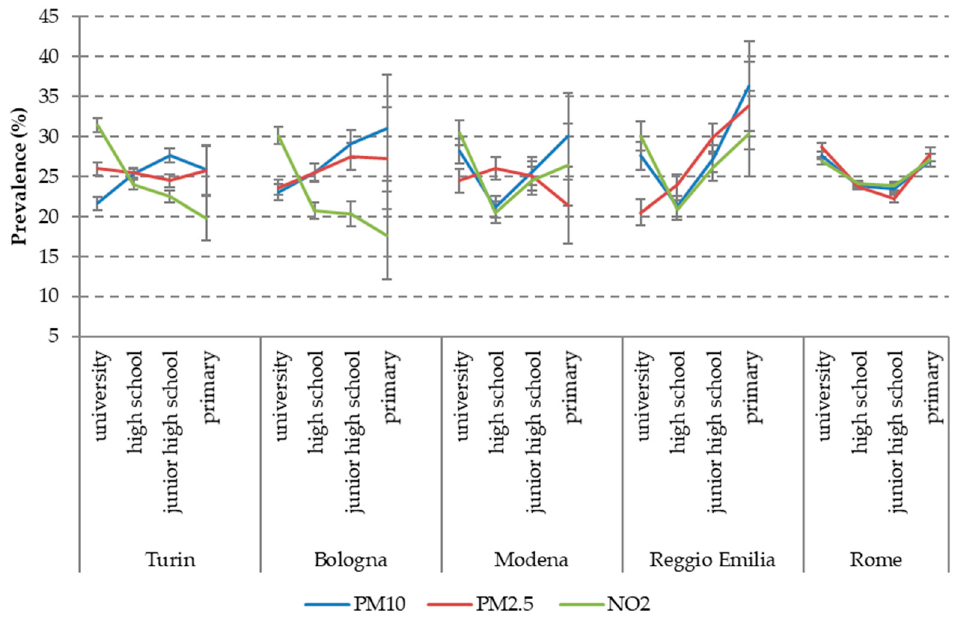
Int. J. Environ. Res. Public Health 2020 , 17 , x Figure 1. Prevalence of high air pollution exposure ( > 75th percentile) by city and maternal education. Figure 1. Prevalence of high air pollution exposure (>75th percentile) by city and maternal education.